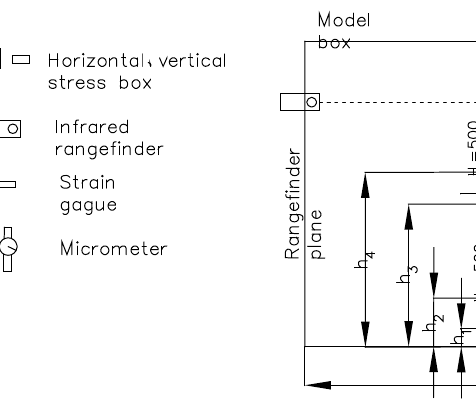
Figure 4: Arrangement of stepped reinforced retaining wall ( unit: mm ) ( condition D2 )